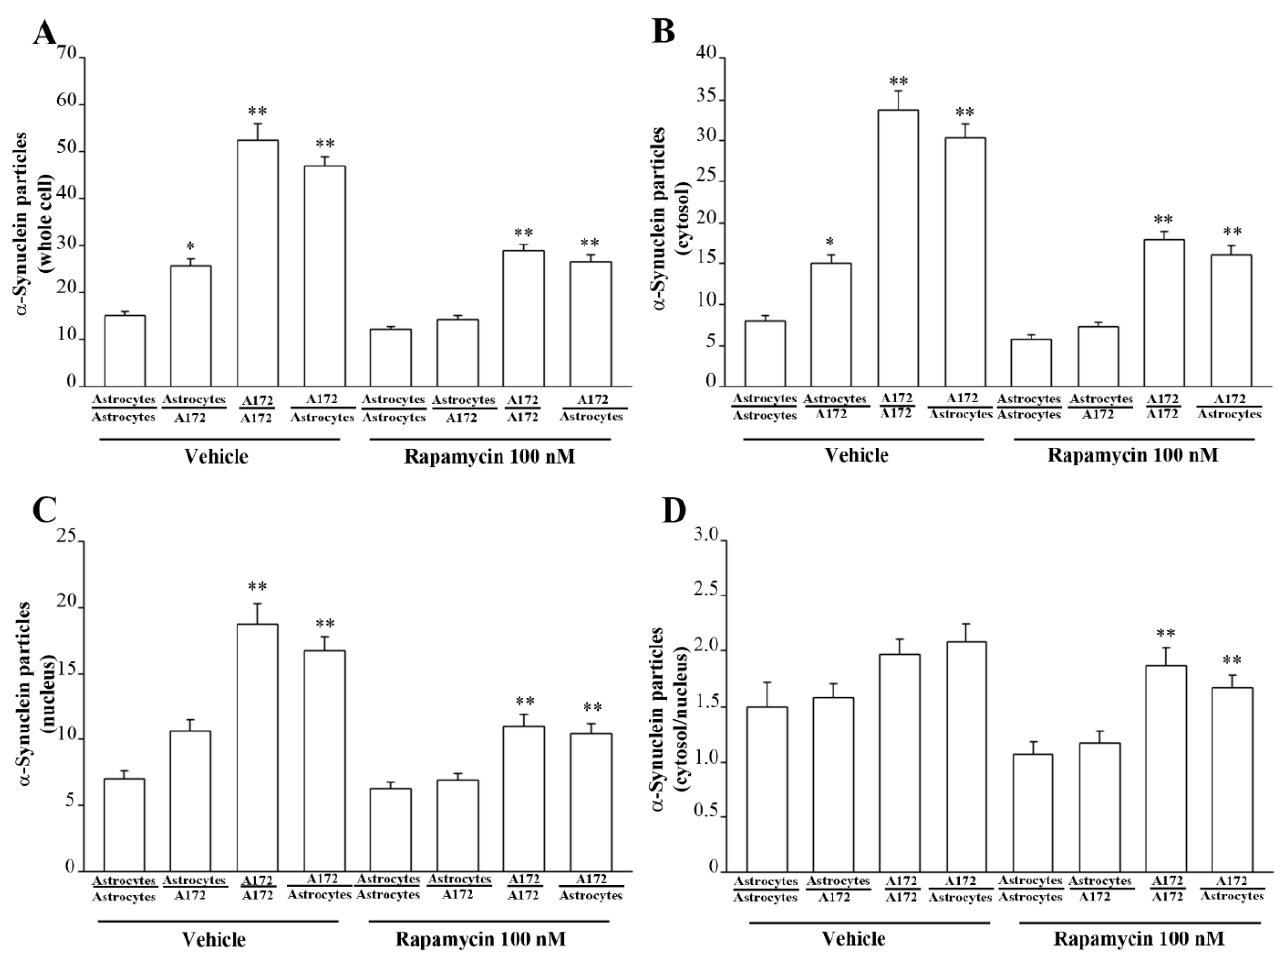
Figure 17. Ultrastructural stoichiometry of α -syn immuno-gold in co-cultures of astrocytes and A172 cells both in baseline conditions and following rapamycin administration. Graphs report the number of α -syn immuno-gold-particles within whole cell ( A ), cytosol ( B ), and nucleus ( C ). The ratio of α -syn immuno-gold particles within cytosol vs nucleus is reported in ( D ). These data are obtained from astrocytes co-cultured with astrocytes, astrocytes co-cultured with A172 cells, A172 cells co-cultured with A172 cells, and A172 cells co-cultured with astrocytes, both in baseline conditions and following rapamycin. Data are given as the mean ± S.E.M. from N = 30 cells per each experimental group. * p < 0.05 compared with astrocytes co-cultured with astrocytes; ** p < 0.05 compared with astrocytes co-cultured with GBM cells.